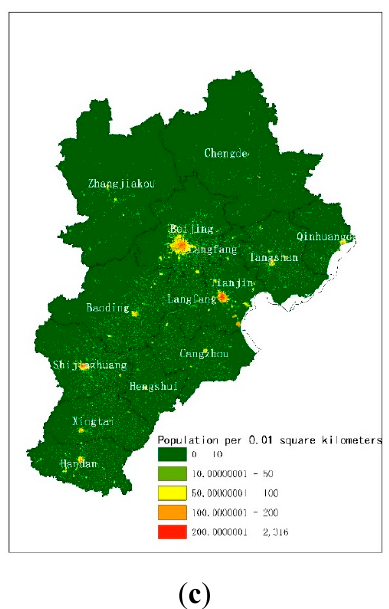
Figure 5. Gridded population map in the Beijing-Tianjin-Hebei (BTH) region from ( a ) population-sensitive POIs (PSP)-driven dasymetric model, ( b ) WorldPop, ( c ) LandScan.